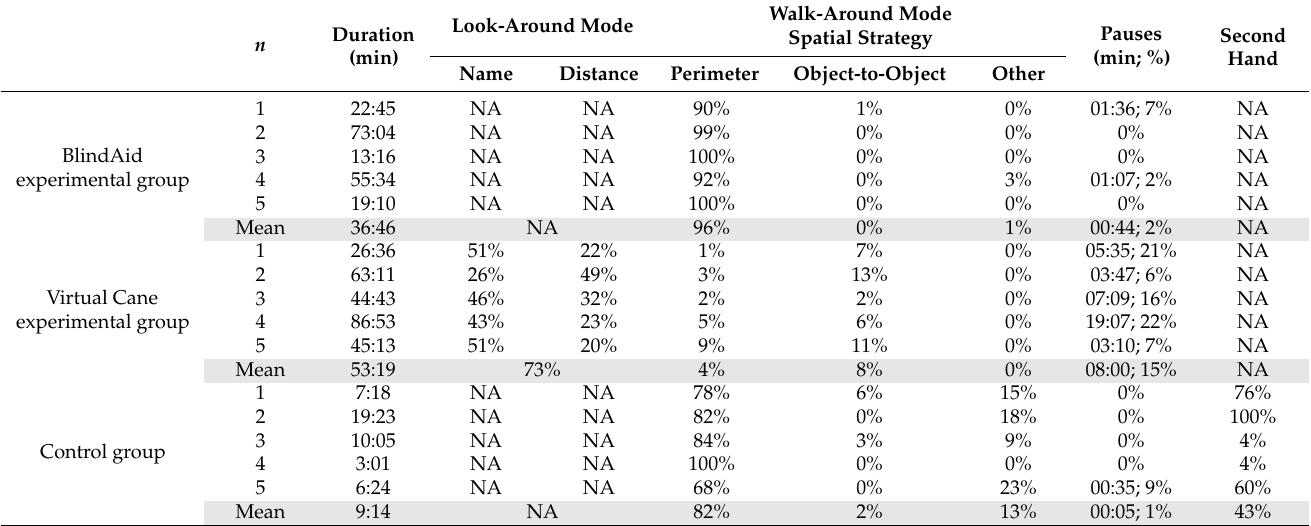
Table 3. Exploration process in complex